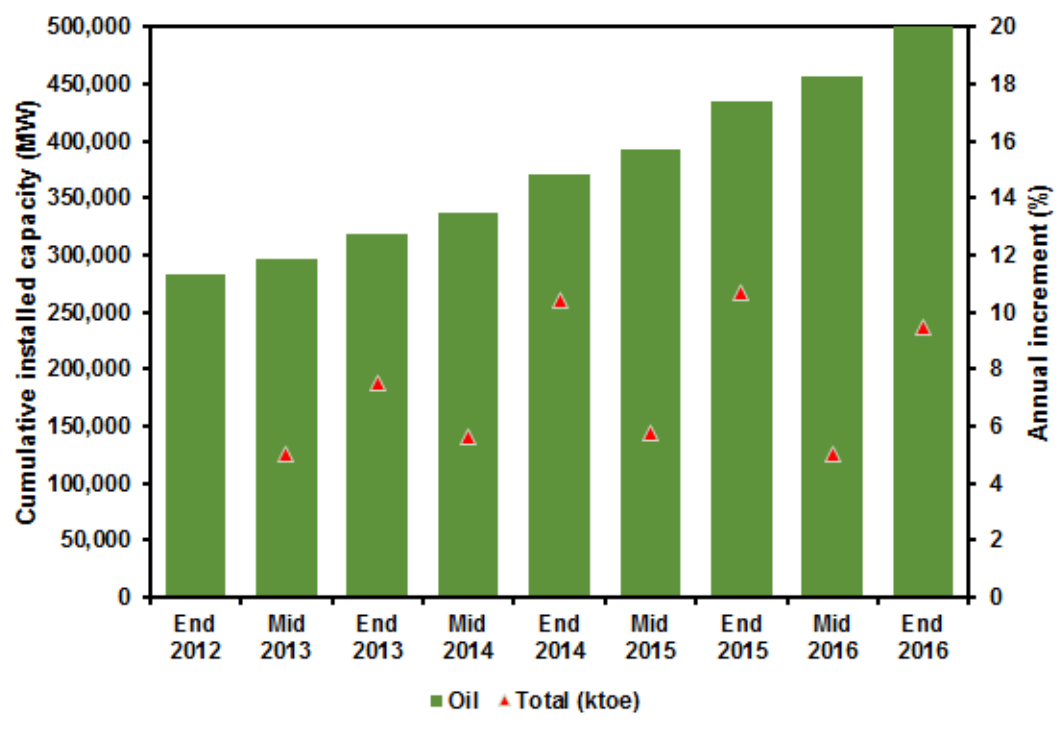
Figure 2. Total installed capacity in the world 2012–2016 in MW. Adapted from [7].